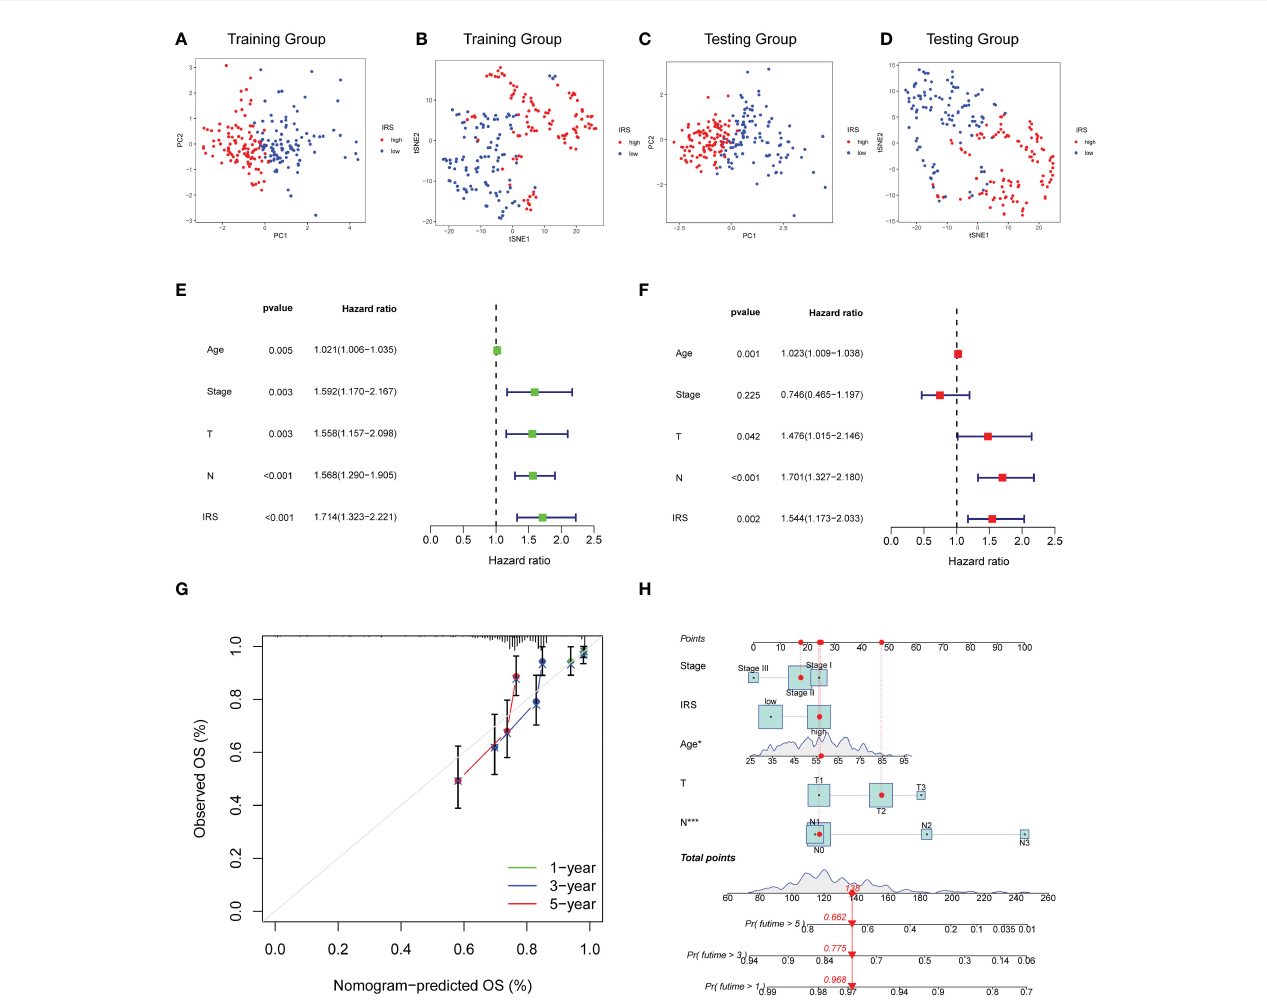
FIGURE 5 Construction of Nomogram for predicting OS in TNBC. (A, B) PCA analysis and t-SNE analysis of TNBC patients based on IRS model for the training cohort. (C, D) PCA analysis and t-SNE analysis of TNBC patients based on IRS model for the validation cohort. (E) Forest plot for IRS and clinical features in TNBC patients by univariate analyses. (F) The multivariate Cox forest plot of IRS and clinical characteristics. (G) Calibration curves for predicting patients ’ OS at 1-, 3-, and 5-year in TNBC patients based on the nomogram. (H) Nomogram depending on the IRS and other clinicopathologic feature predicting the 1-, 3-, and 5-year overall survival for TNBC